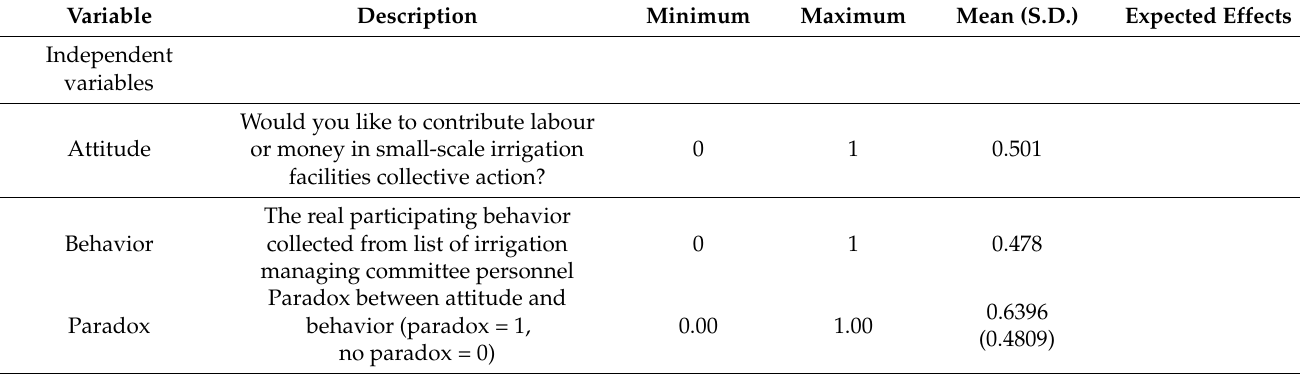
Table 1. Descriptive statistics of main